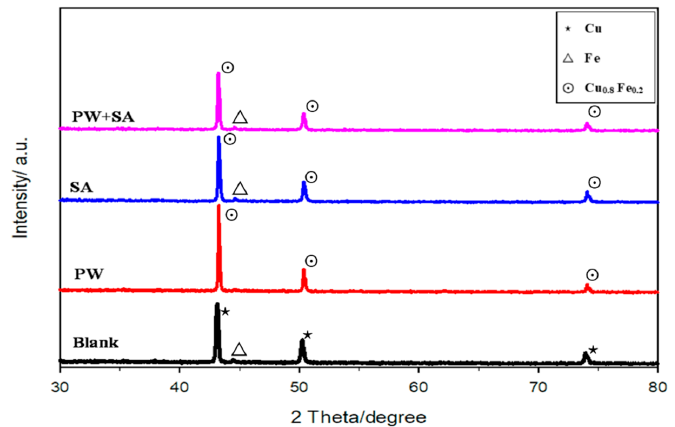
Figure 9. XRD analysis of the Cu–15Fe sintered samples with different amounts of composite lubricant at 200 MPa.